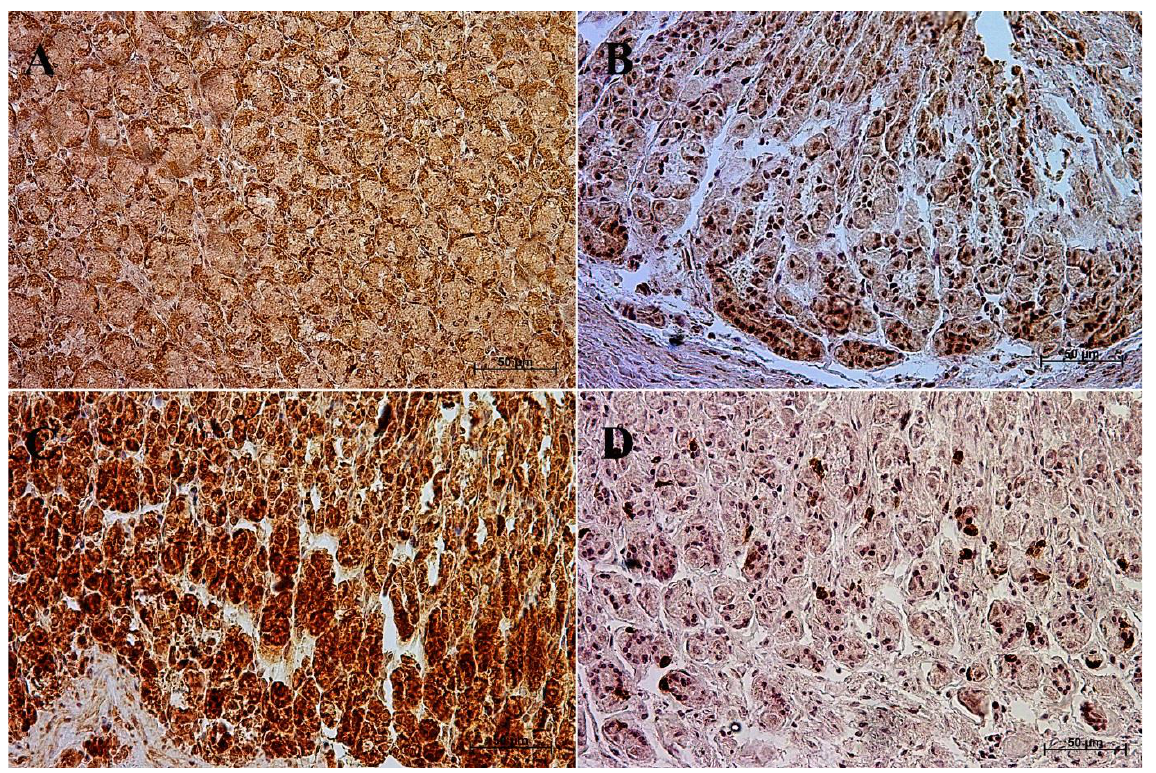
Figure 1. Positive control reaction for each cell marker (murine gastric mucosa), 40×. ( A ) gastrin, ( B ) cholecystokinin, ( C ) secretin receptors, ( D ) somatostatin.